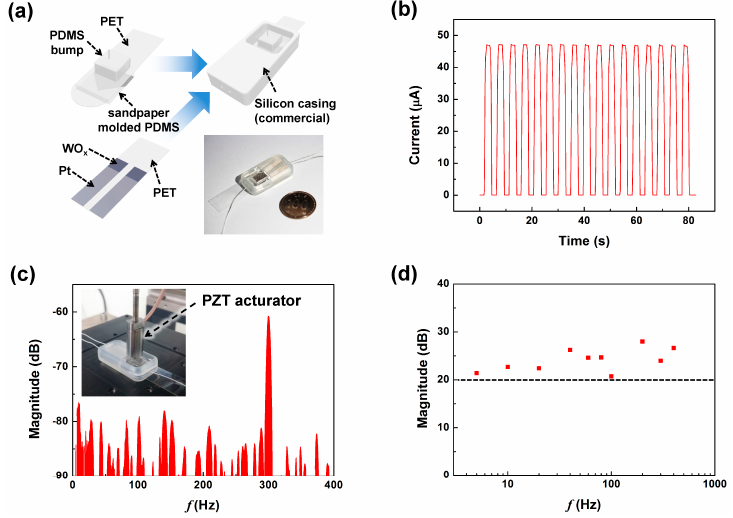
Figure 5. The repeatable pressure sensing operation of dSMP sensor; ( a ) the assembly process of the dSMP sensor, where the inset shows the optical image of the fabricated dSMP sensor; ( b ) the output current of the dSMP sensor during repeated cycles of 1.5 kPa; ( c ) the fast Fourier transform data of the dSMP senor by applying 300 Hz of vibrational pressure, where the inset shows a measurement set-up with PZT acturator, and ( d ) the magnitude of main peak of the dSMP sensor output, which was obtained by subtracting the base line from the main peak, depending on the input vibration frequency between 5~400 Hz, where the black dash line shows 20 dB.